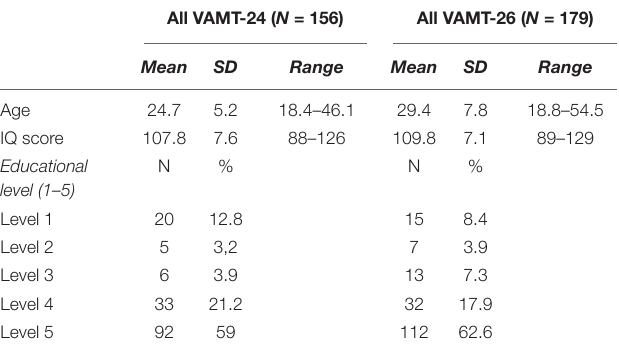
TABLE 3 | Descriptive information for the healthy samples in Part